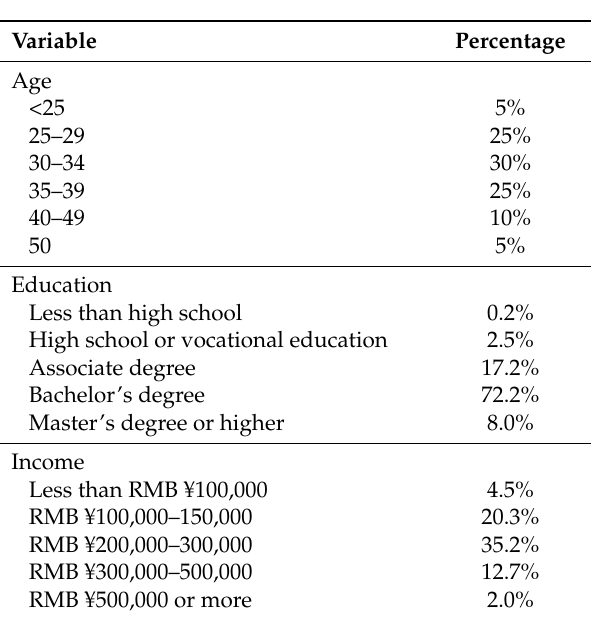
Table 1. Participants’